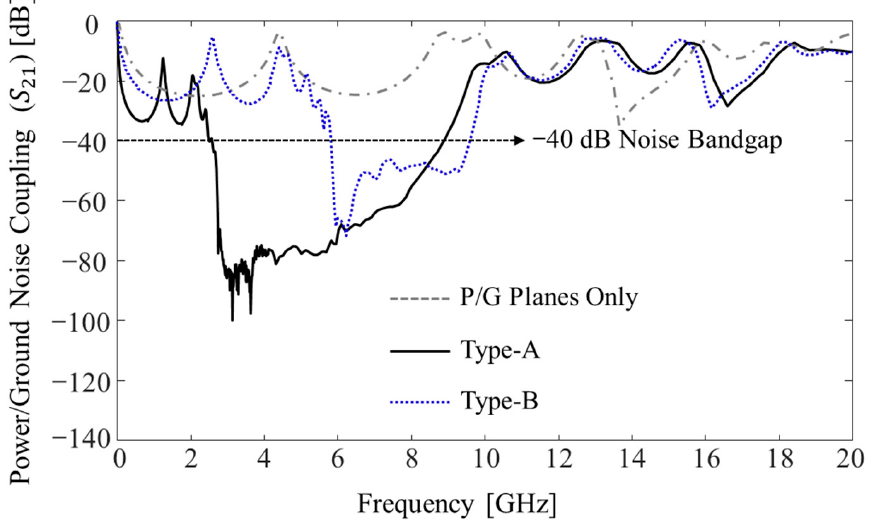
Figure 8. Comparison of the measured power/ground noise couplings ( S 21 ) in the PDN.